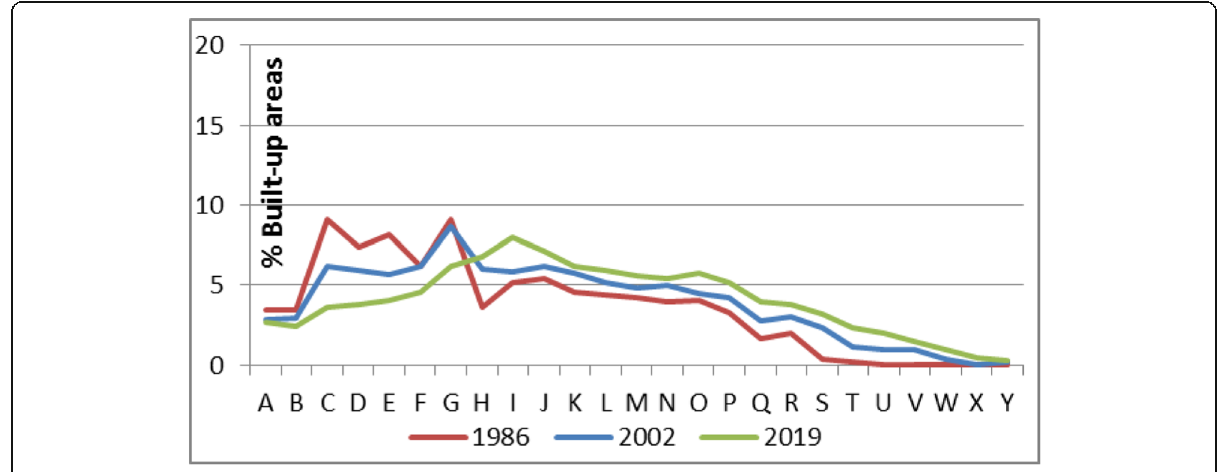
Fig. 5 Percentage of the urban built-up area within each ring